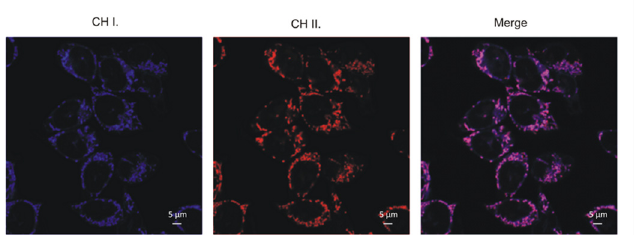
Fig 5. In vitro staining of HCT116 cells treated with 6b (CH I.) and MitoTracker Orange CMTMRos dye (CH